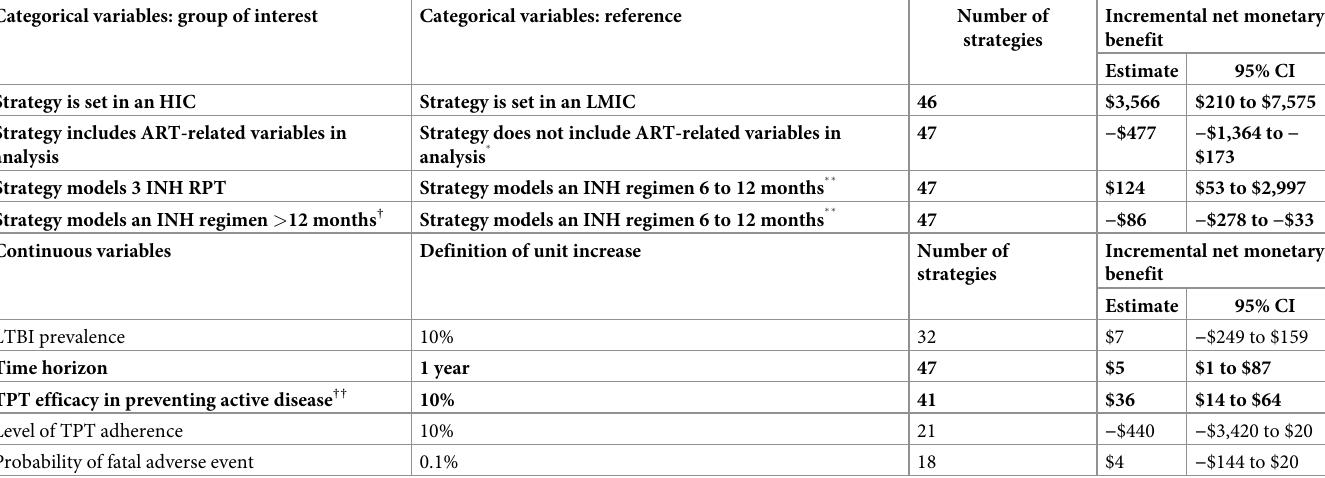
Table 4. Univariable regression models: incremental net monetary benefit comparing TPT to no TPT (2020